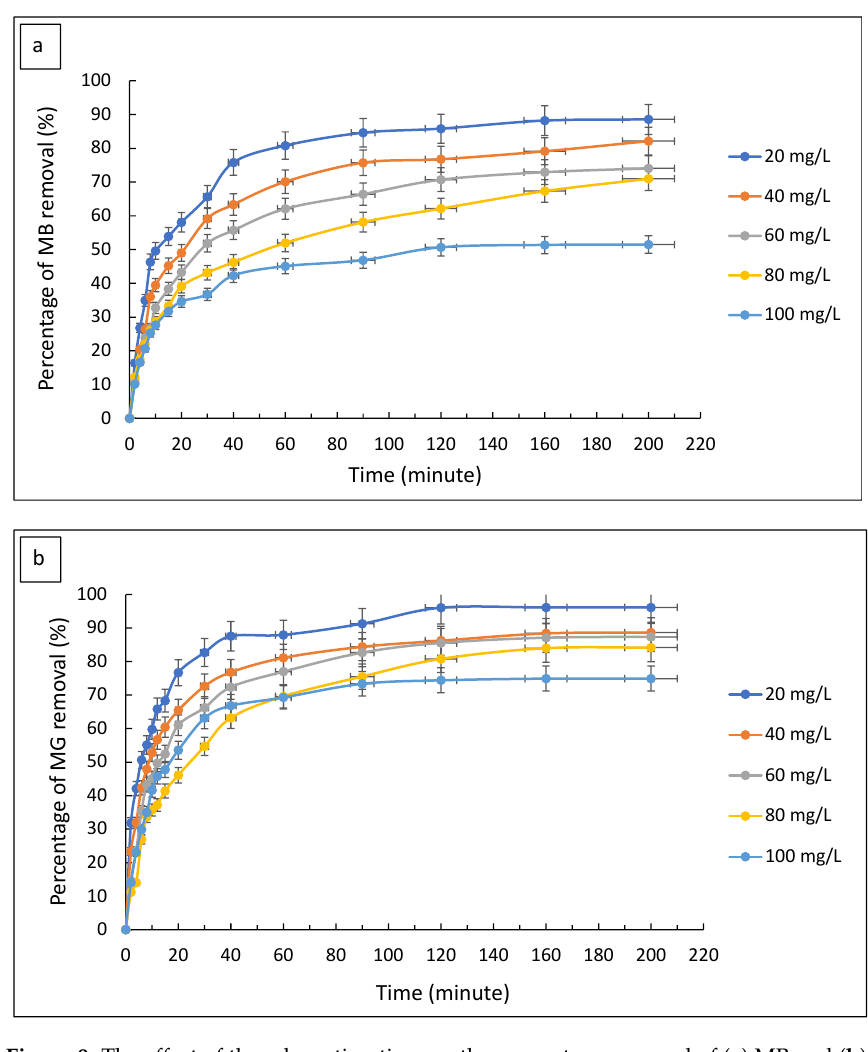
Figure 9. The effect of the adsorption time on the percentage removal of ( a ) MB and ( b ) MG.